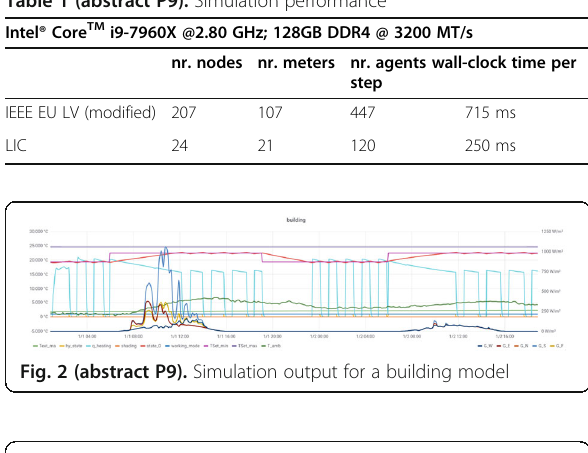
Table 1 (abstract P9). Simulation performance